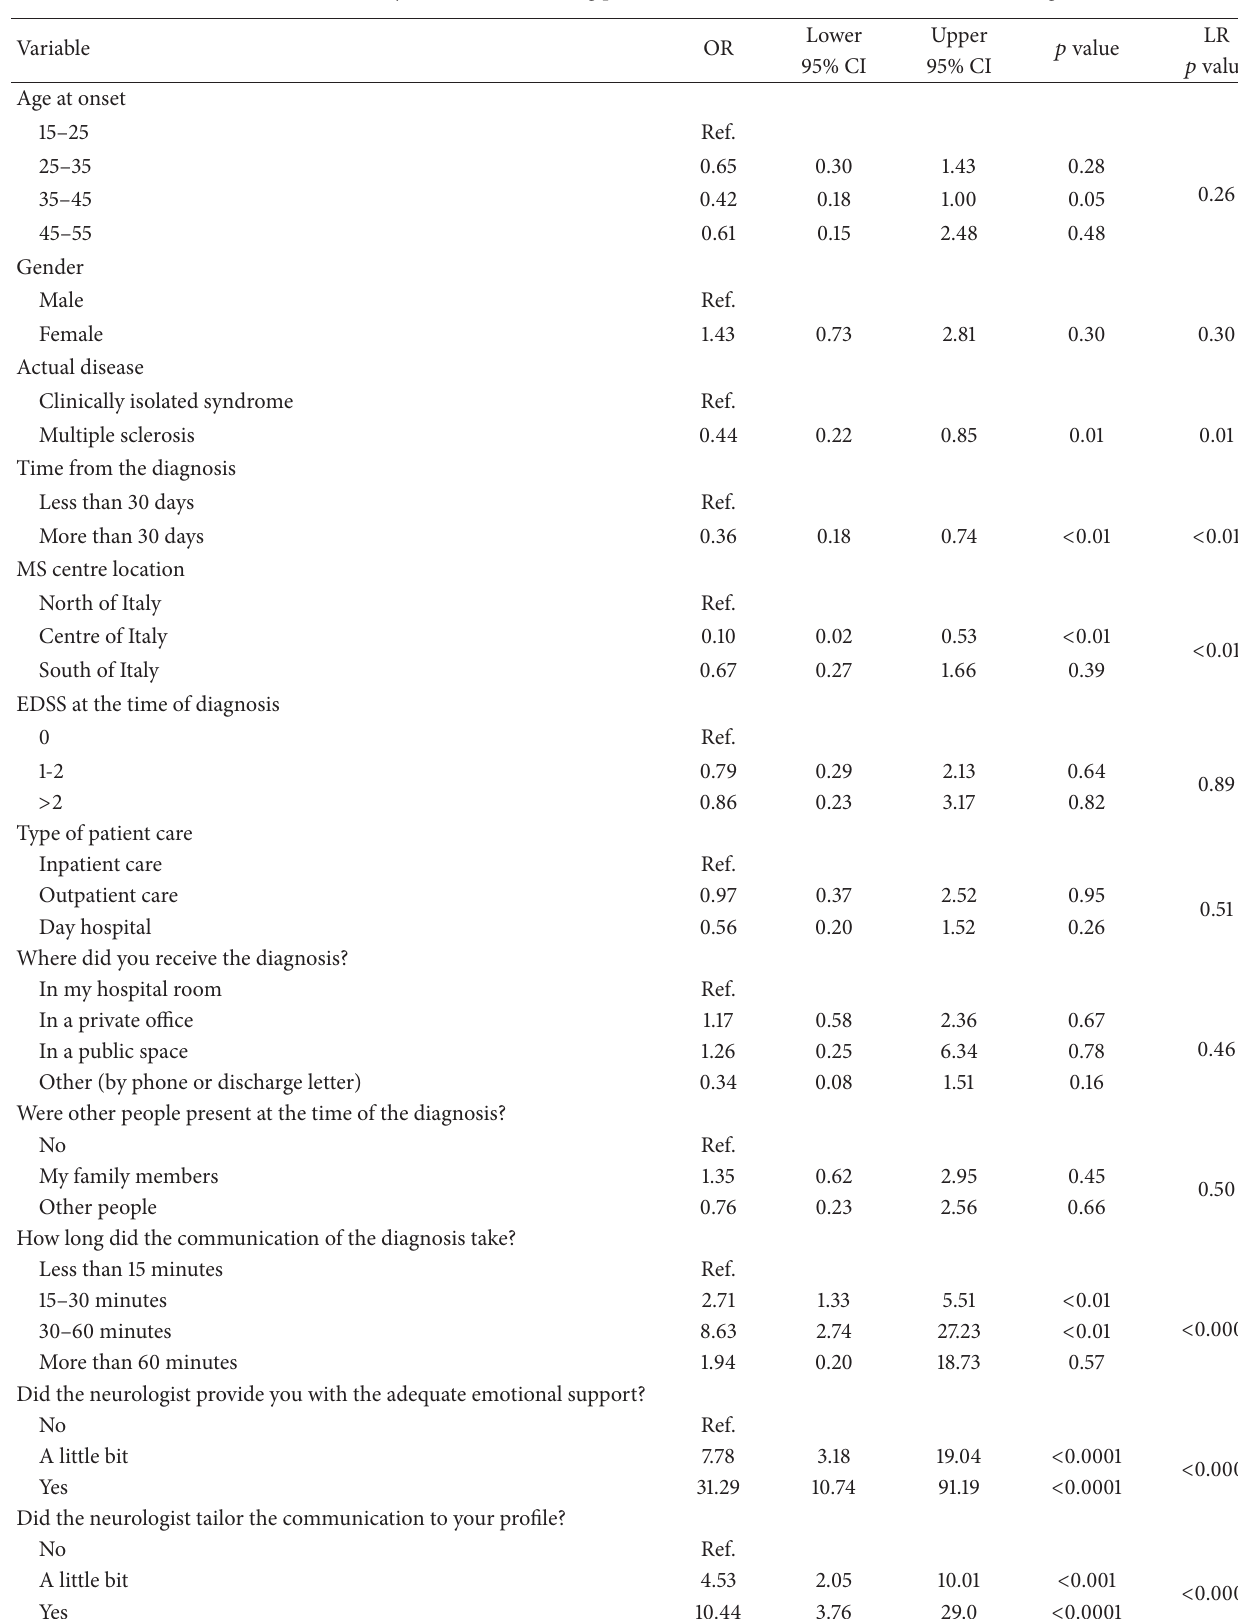
Table 4: Multivariate analysis of factors affecting patients’ satisfaction with the disclosure of the